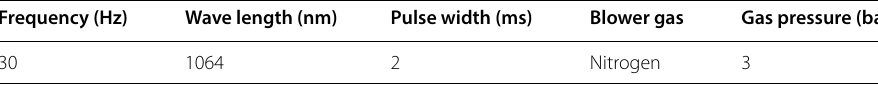
Table 1 Laser specifications n numerical analysis [2]